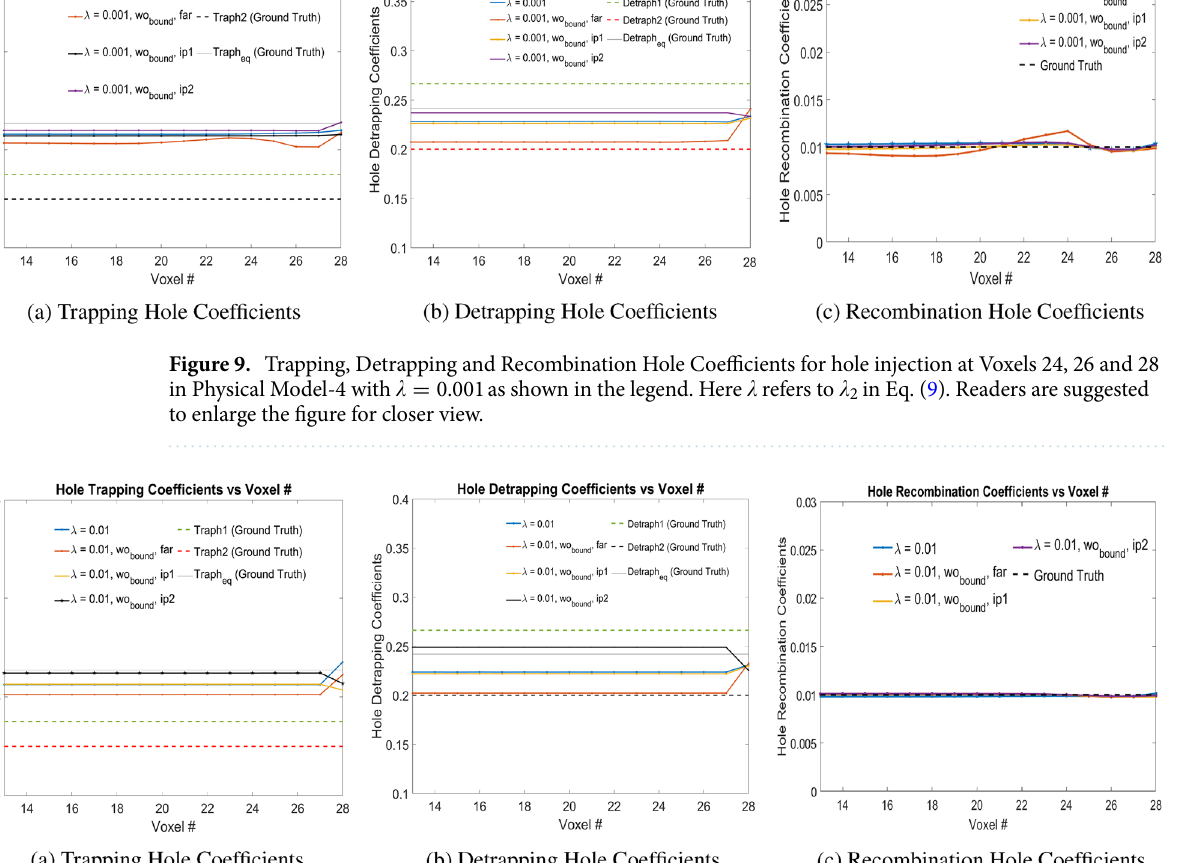
Table 4. The electron-hole pair injections are at Voxels 81, 84 and 87. It is seen that for (cid:31) 1 = 0.1 in Eq. (9), the mean error value has the minimum value of 0.0638. During training, the bounds on trapping, detrapping and recombination weights for electrons are bounded in [0.004, 0.012], [0.008, 0.02] and [0.0005, 0.005] respectively,